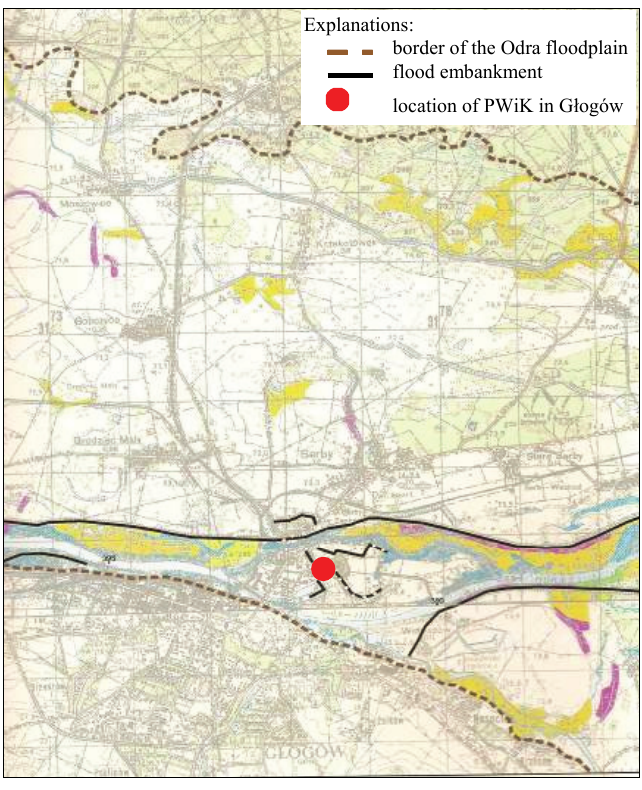
Fig. 1. The location of the PWiK Głogów facilities in relation to the Odra floodplains (scale 1:30000)